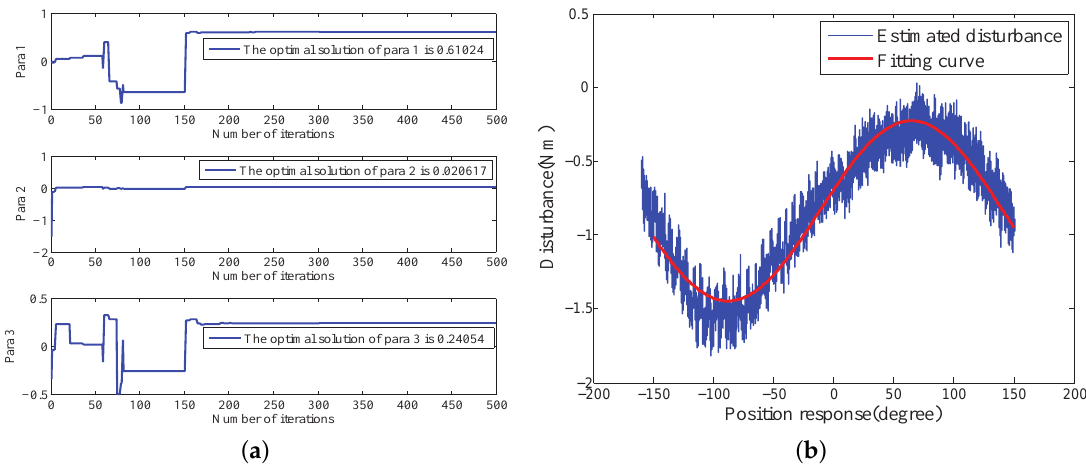
Figure 10. Parameter identification and optimization when velocity > 0: ( a ) Parameter convergence; ( b ) Optimal fitting.